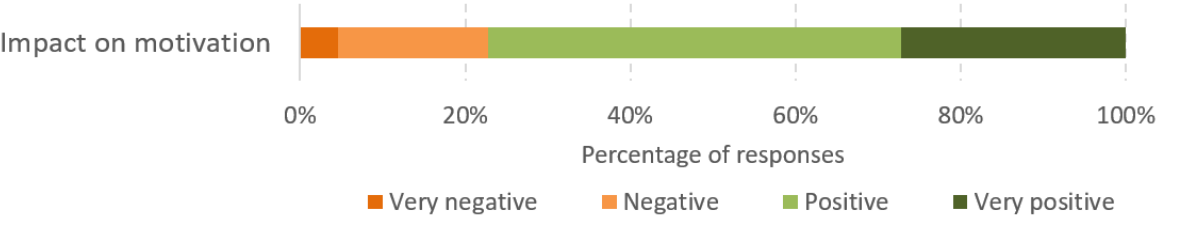
Figure 9. Sentiment analysis using NVivo on the impact of various aspects of HeartHab on motivation to be more physically active.